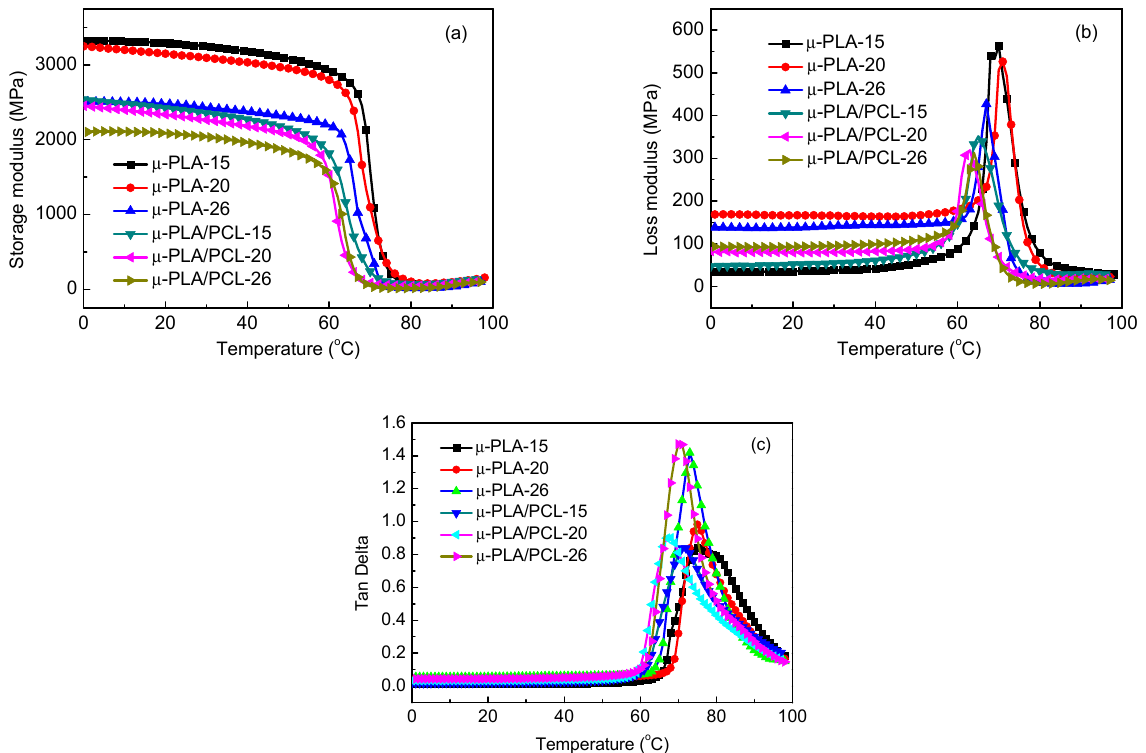
Figure 8. The dynamic mechanical analysis results of microparts with different cavity size as a function of temperature: ( a ) storage modulus, ( b ) loss modulus, and ( c ) tan δ . Table 5. The glass transition temperature (T g ) of pure polylactic acid (PLA) and PLA/PCL blend micropart with different cavity size in DMA test.